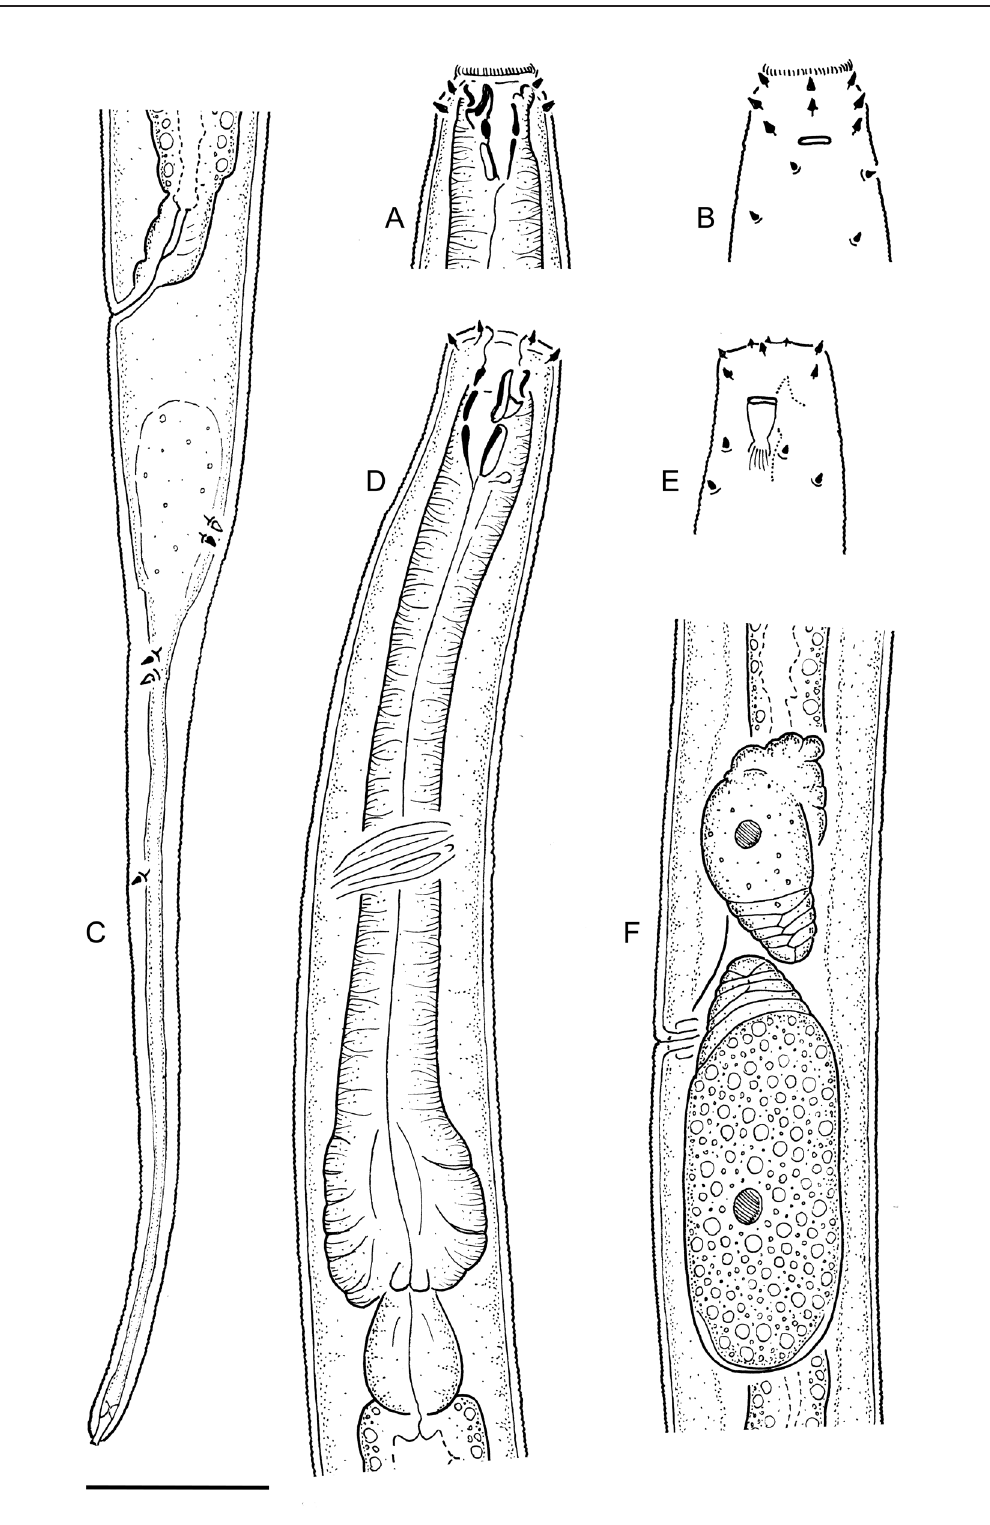
Fig. 2 . Campydoroides manautei Holovachov gen. et sp. nov. A – B . Paratype female (SMNH Type- 9167). C – F . Holotype (MNHN-BN511). A . Female pharyngeal region, median section. B . Female anterior end, median section. C – D . Female anterior end, surface view. E . Female reproductive system. F . Female tail. Scale bar: 20